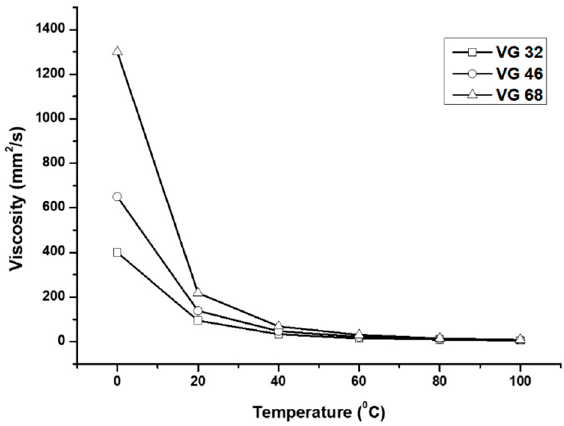
Figure 7. The viscosity of the hydraulic oils at various temperatures.